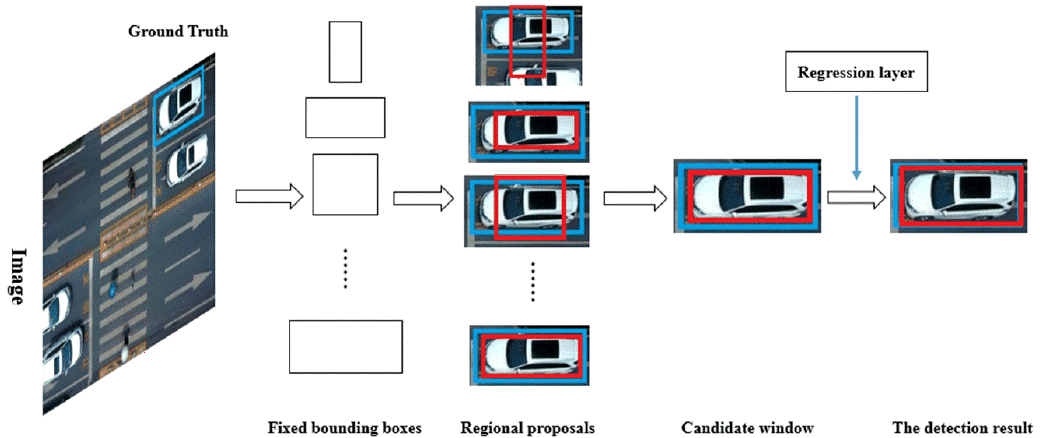
Figure 9. Acquisition of test results.